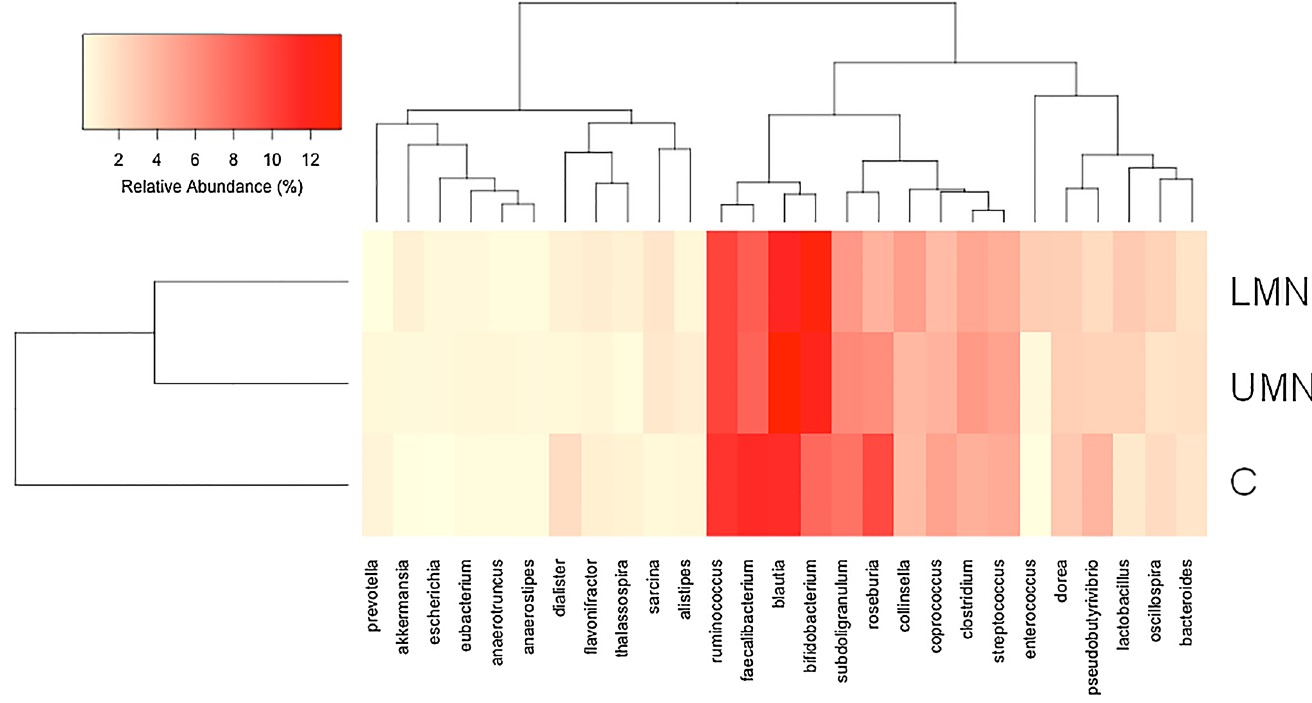
Fig 3. Hierarchical cluster analysis showing the relative percent abundance of each genus in the study groups. UMN: Upper motor neuron group; LMN: Lower motor neuron group; H: Healthy controls.